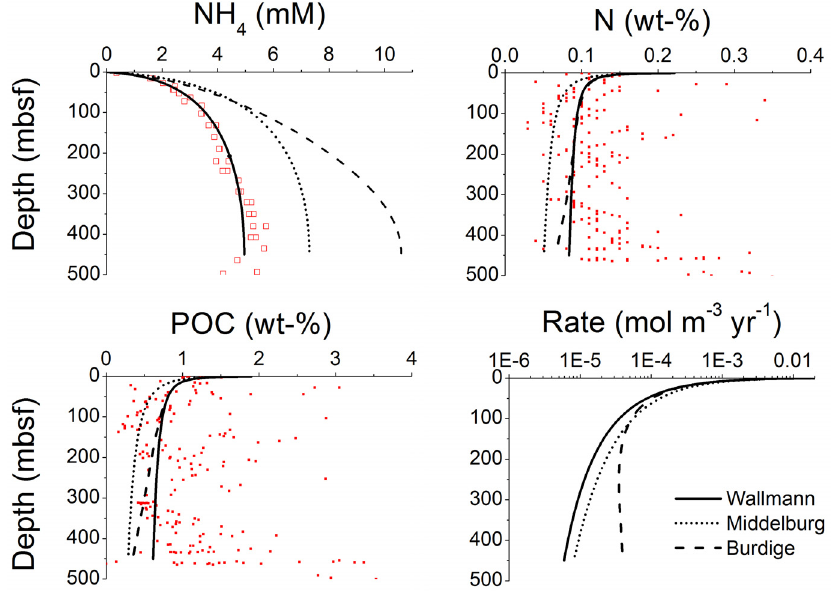
Figure 29. Model results for ODP site 799A. Concentrations of dissolved ammonium ), particulate nitrogen (N), particulate organic carbon (POC) and POC degradation rates (NH 4 obtained applying the kinetic rate laws introduced by Wallmann et al . [Equation (11)], Middelburg [Equations (7,8)] and Burdige [Equation (35)] with an activation energy of E = 50 kJ mol − 1 . N concentrations are the sum of particulate organic nitrogen (PON) and a adsorbed ammonium. Symbols indicate the data measured at ODP site 799A while lines indicate model